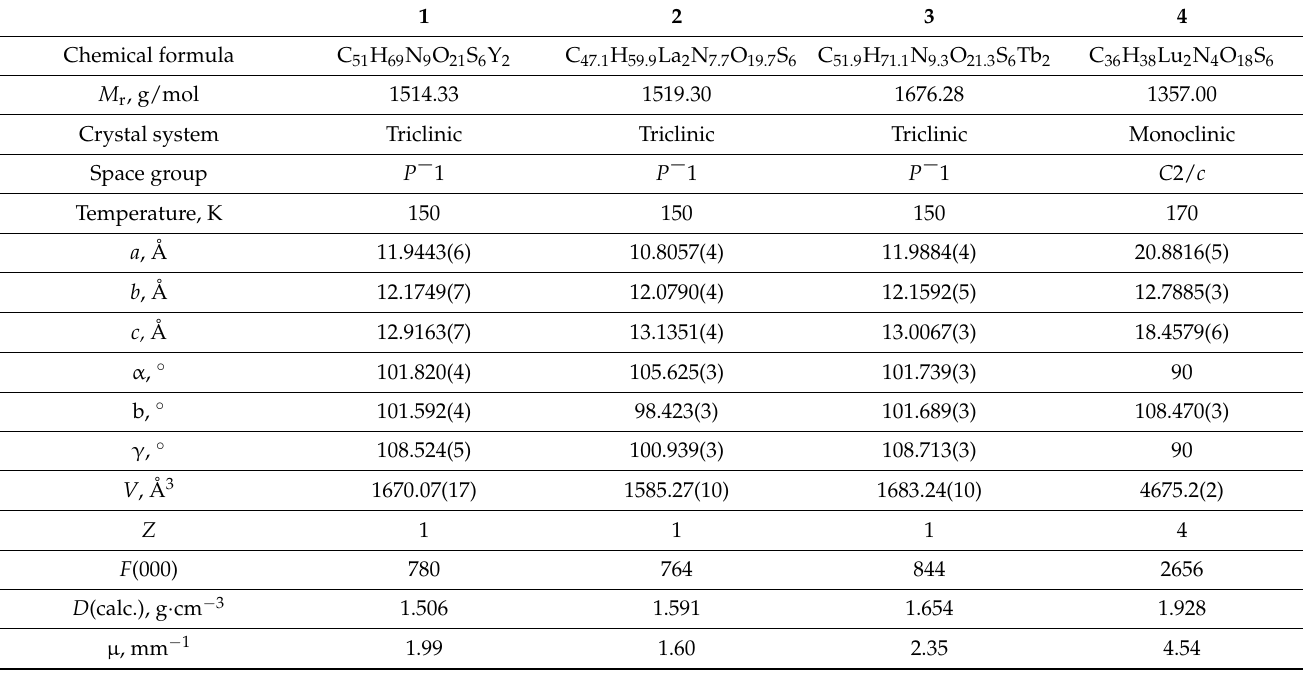
Table A1. Single crystal X-ray diffraction analysis and structure refinement